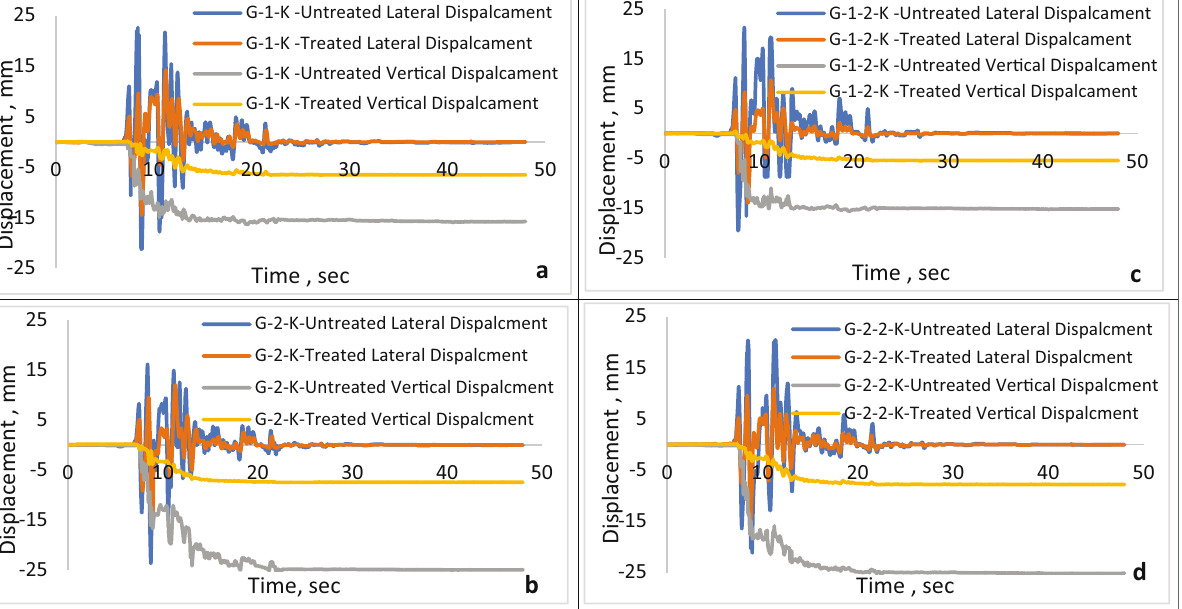
Figure 5: Vertical and lateral displacements of the pile group in the treated and untreated soil with nano - SiO 2 at ( a ) 50% axial load, ( b ) 100% axial load, ( c ) 50% axial load and 100% lateral load, and ( d ) 100% axial load and 100% lateral